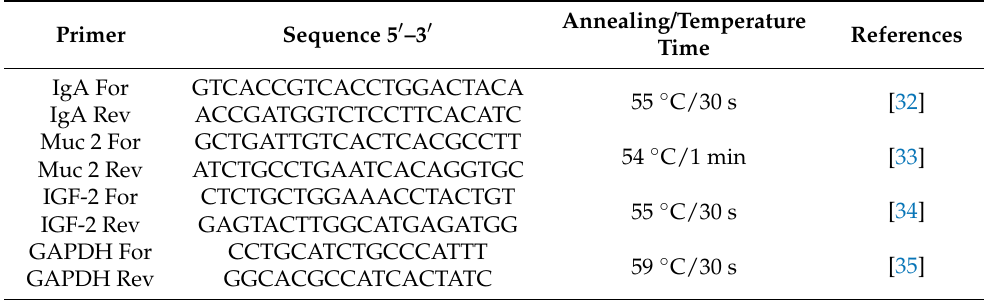
Table 2. List of primers used in RT-PCR for IgA, MUC-2, and IGF-2 mRNA detection in layer hens.